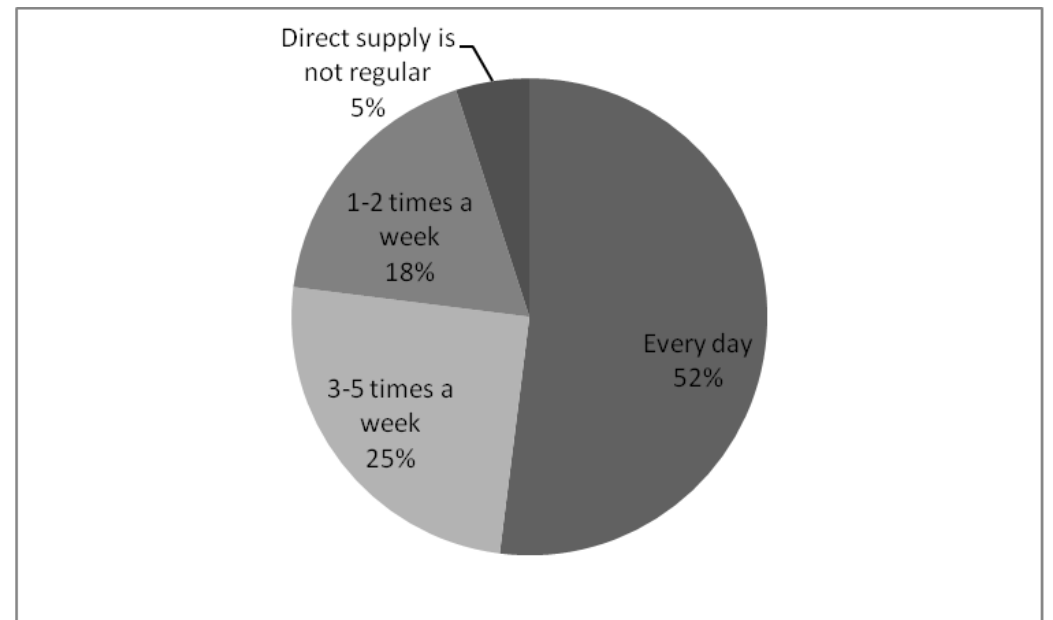
Figure 1. The results of the answer to the question “How many times do you eat per day?“ Table 2. Percentage Distribution of Athletes According to the Number of Snacks Depending on the Sport Groups